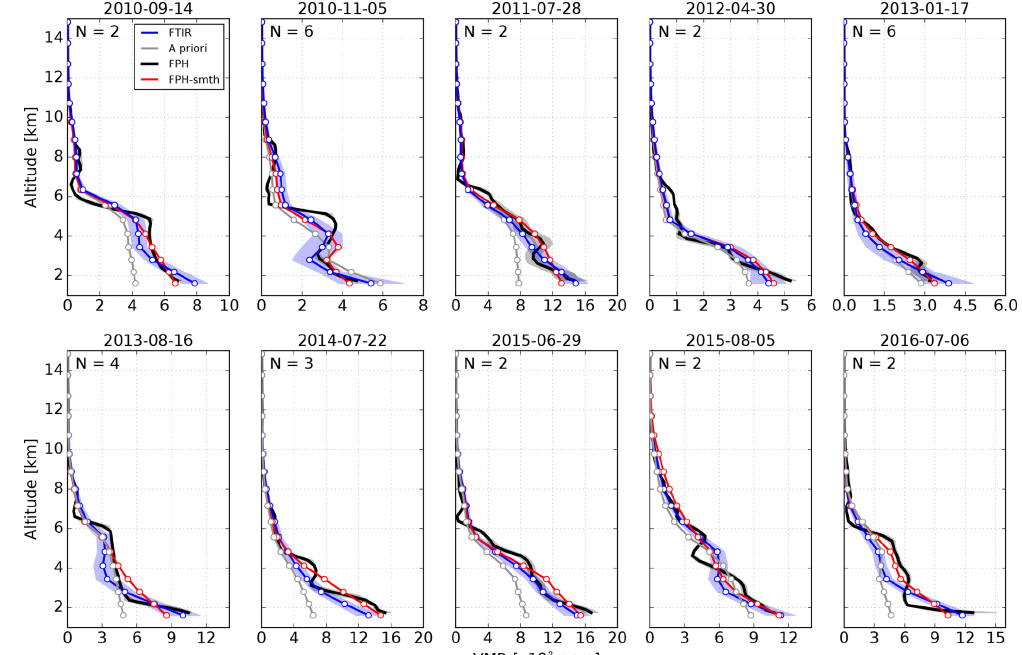
Figure 4. WV vertical profiles for selected dates obtained with unsmoothed in situ NOAA FPH measurements (black) and FTIR retrievals (blue) in BLD. The ERA-d WV used as the a priori profile is shown in gray. The dates are shown at the top of each plot. The FTIR profiles represent weighted mean profiles using retrievals within 2h of the radiosonde launch. The filled blue shadow area represents the standard error propagation using the uncertainty in individual retrievals. The gray shaded areas are FPH profiles of the 1-sigma standard deviation of each mixing ratio. The number of retrieved profiles within 2h is shown in the upper left of each panel.